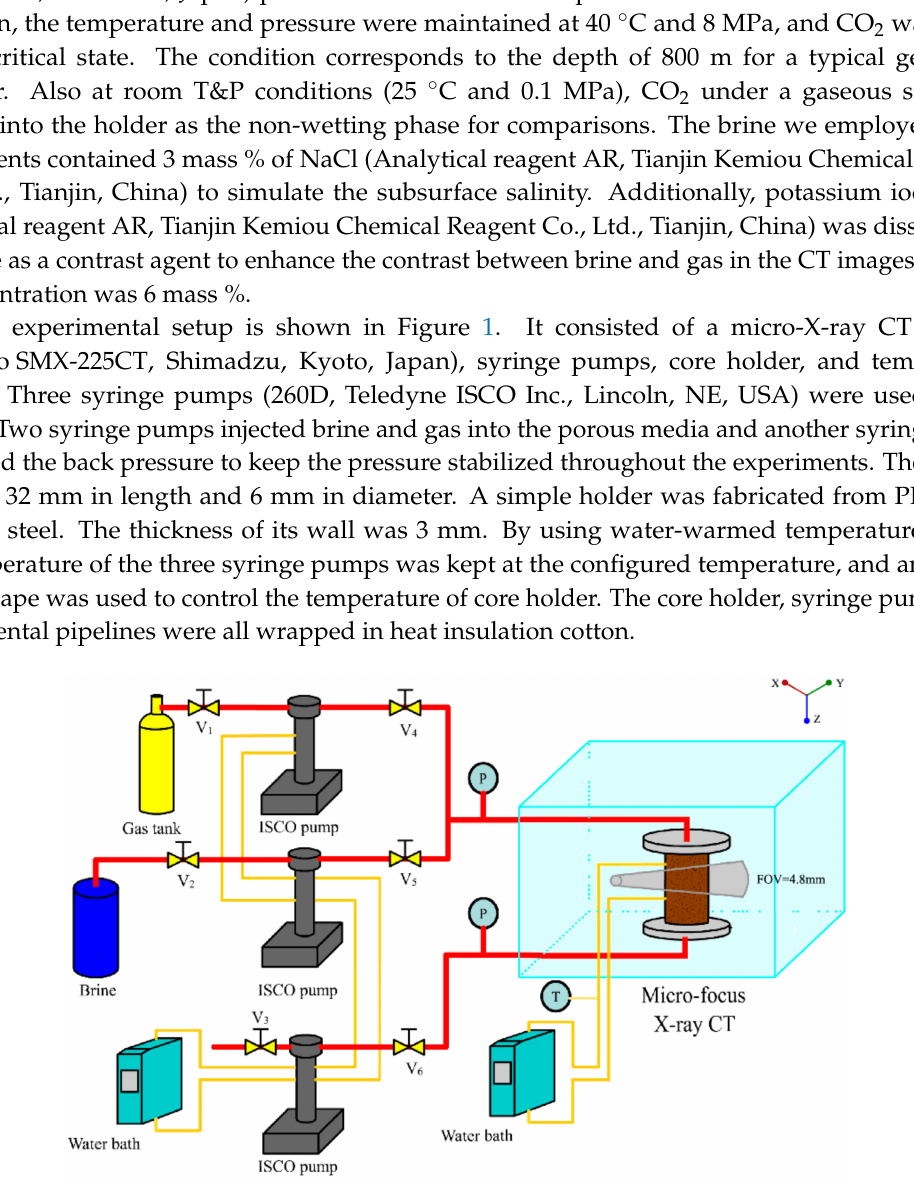
Figure 1. Experimental apparatus. The syringe pumps, ISCO pumps, were used as injection pumps and back pressure pump. The micro–computed tomography (Micro-focus X-ray CT) was configured under the same parameters between different sets of experiments. The length of the FOV (field of view) of the packed beads was 4.8